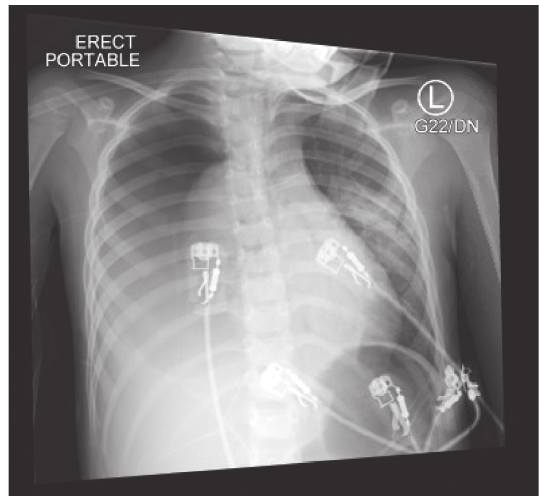
Figure 1: Large right pneumothorax; left perihilar and retrocardiac opacities with cystic changes concerning for infection; right pleural effusion.